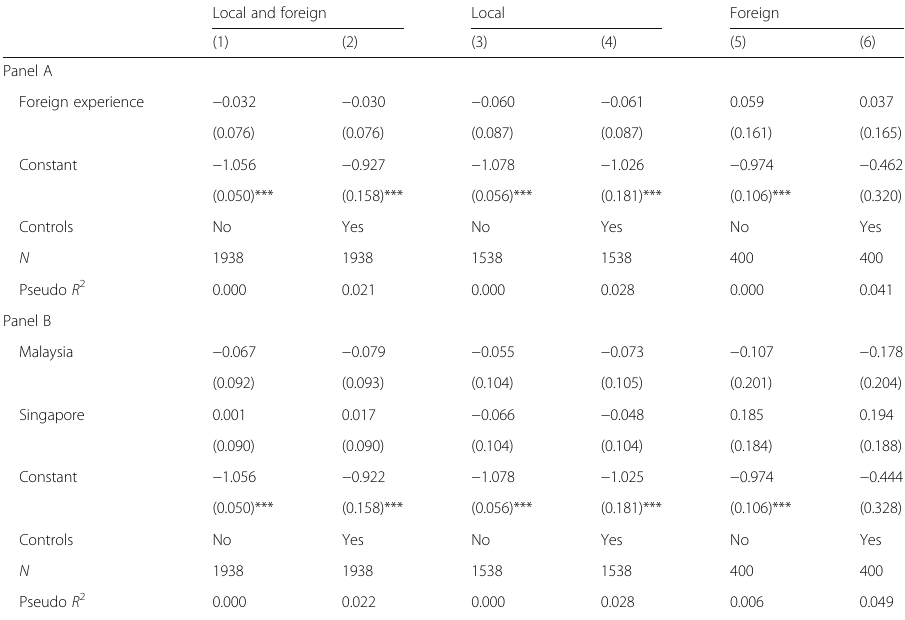
Table 13 Dependent variable: if a resume is the first to receive a callback for an interview (all